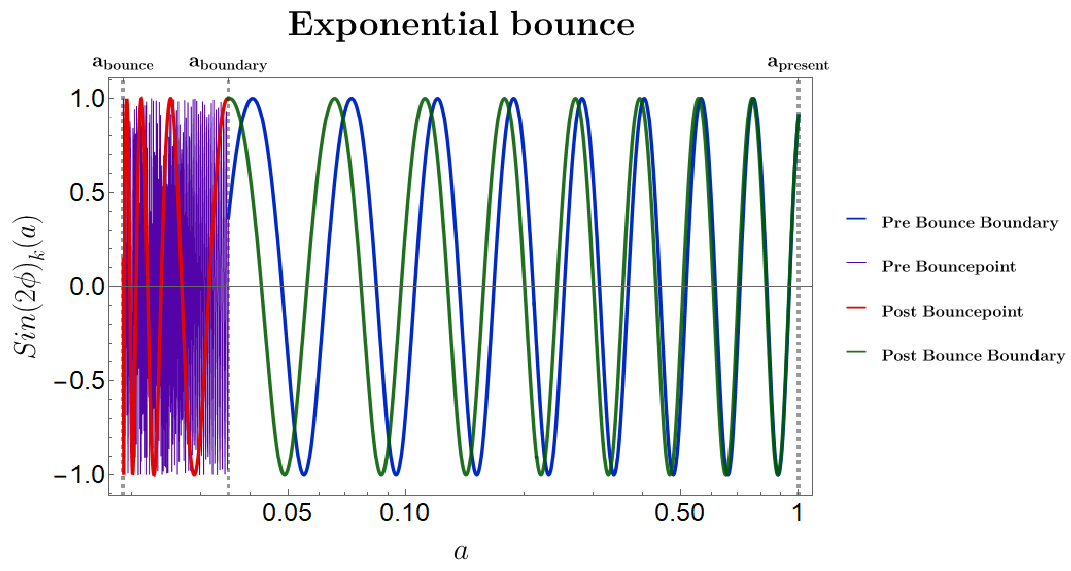
Figure 28: Sine of twice of squeezing angle at different regions plotted against scale